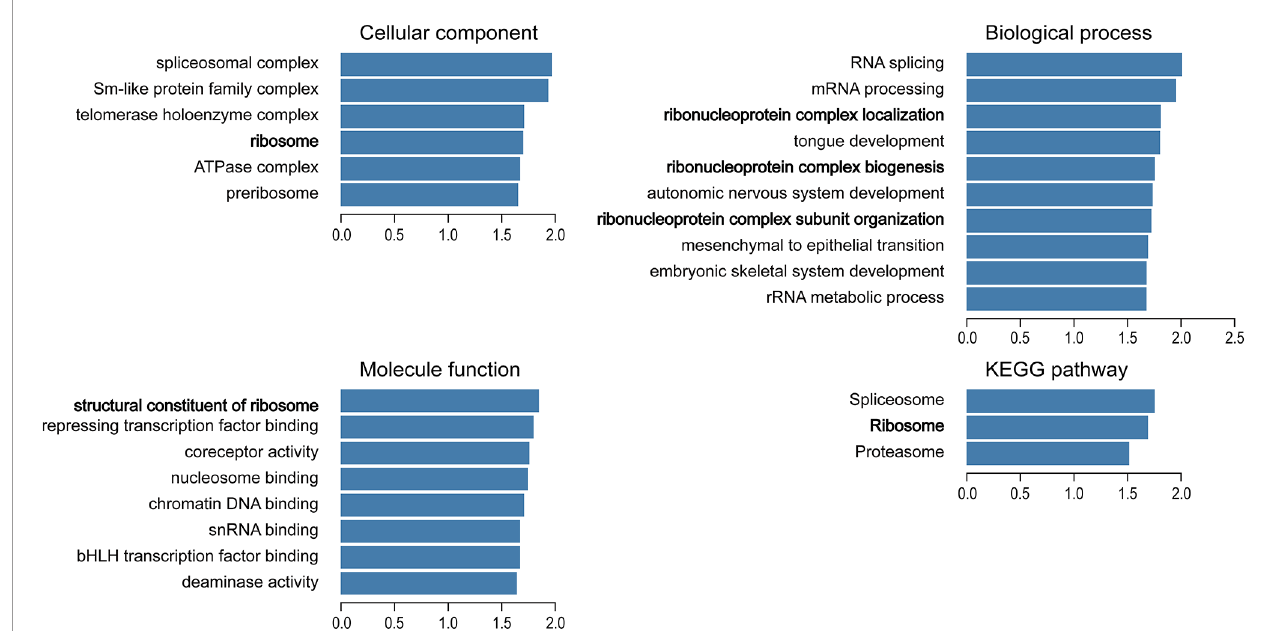
FIGURE 2 | Analysis of signi fi cantly enriched GO annotations and KEGG pathways of differentially expressed genes correlated with TBX1 from PCa patients in the TCGA database using GSEA. The blue column represents the normalized enrichment scores. FDR < 0.05. Gene Ontology, GO; Gene Set Enrichment Analysis,